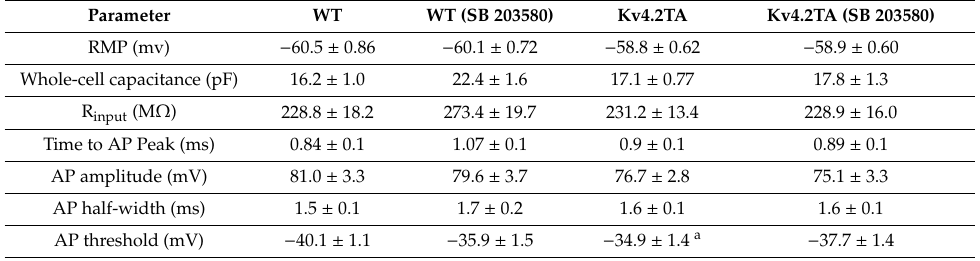
Table 1. Passive membrane properties and single action potential (AP) parameters (mean ±